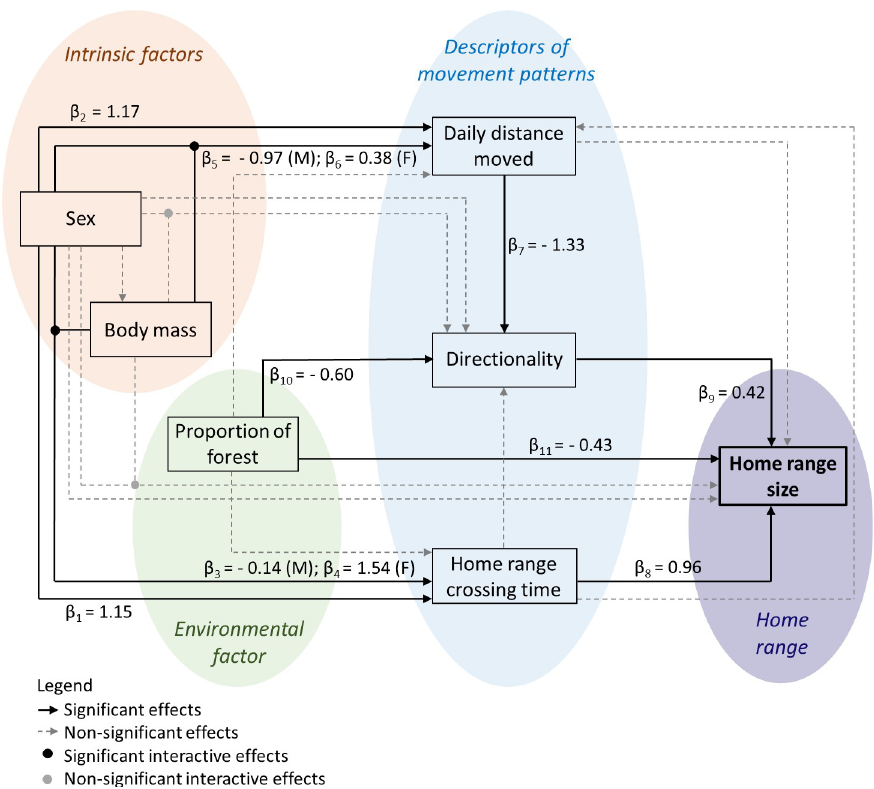
Fig 2. Schematic representation and estimated coefficients of the intrinsic (sex and body mass) and environmental effects (proportion of forest patches inside the home range) on movement patterns (described by home range crossing time, daily distance moved and directionality) and home range size of giant anteaters ( Myrmecophaga tridactyla ), as well as of the relationships between the descriptors of movement patterns to each other and with home range size. The standardized coefficients ( β ) represent the relative strength of significant